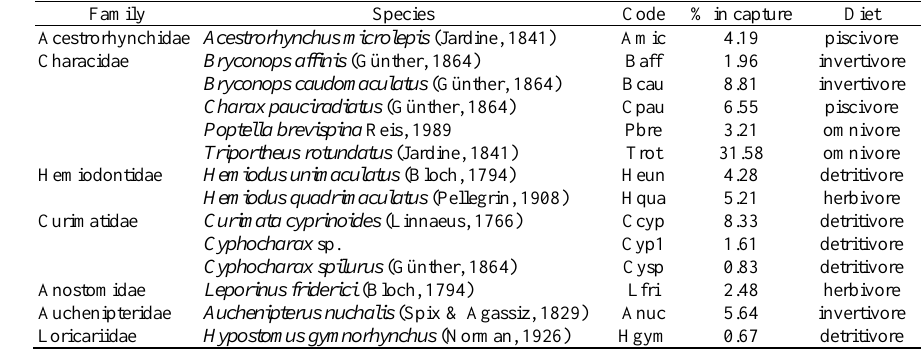
Table 1. List of analyzed fish species with indication of their relative abundance in Petit-Saut Reservoir and of their diet from Mérona et al . (2003).